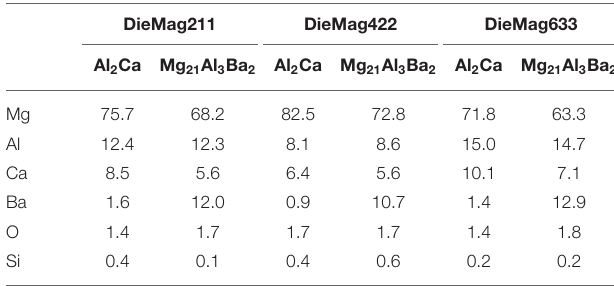
TABLE 5 | EDXS point measurements (wt.%) of Al 2 Ca or Mg 21 Al 3 Ba 2 intermetallic phases in DieMag